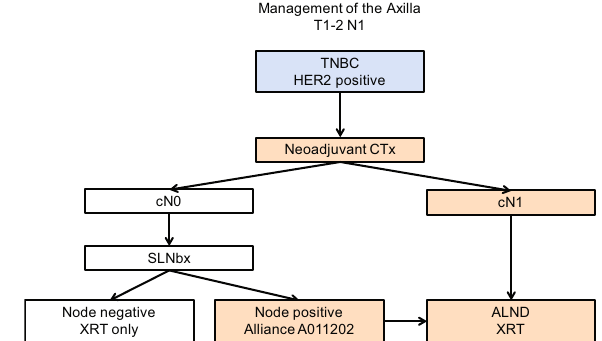
Fig. 1 Suggested management of the axilla with T1/T2 N1 disease who are triple negative or HER2 ampli fi ed. (Patients who are cN0 after neoadjuvant chemotherapy and have a positive sentinel node may be candidates for the Alliance A011202 trial, which randomized patients to a full axillary lymph node dissection versus none; all patients will receive radiation therapy). TNBC triple-negative breast cancer, HER2 human epidermal growth factor receptor 2, CTx chemotherapy, SLNB sentinel lymph node biopsy, XRT radiation therapy, ALND axillary lymph node